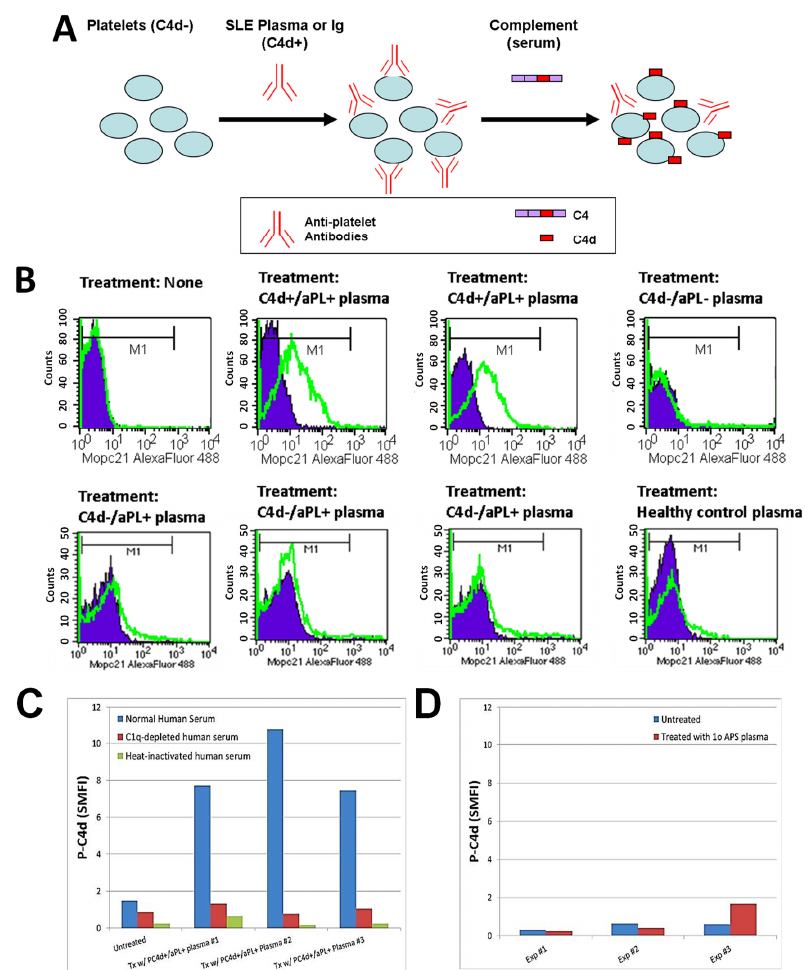
Figure 1. Induction of C4d deposition on the surface of platelets in vitro. ( A ) Schematic illustration of the in vitro P-C4d induction experiments. C4d-negative (C4d − ) cells are incubated with plasma or Ig isolated from C4d-positive (C4d+) SLE patients, and subsequently with normal human serum (complement). After treatment, levels of C4d deposited on platelet surfaces were analyzed by flow cytometry; ( B ) Platelets from a healthy individual were incubated with the plasma of two P-C4d+/aPL+ SLE patients, one P-C4d − /aPL − SLE patient, three P-C4d − /aPL+ SLE patients, and one healthy control, followed by incubation with complement. Note the high levels of C4d deposited on cell surfaces after treatment with P-C4d+/aPL+ SLE plasma, but not with P-C4d − /aPL − SLE plasma, P-C4d − /aPL+ SLE plasma, or healthy control plasma. Purple histogram: isotype control; green open histogram: anti-C4d; ( C ) C4d deposition was induced in vitro only when platelets were treated with P-C4d+/aPL+ plasma, followed by normal human serum. C1q-depleted or heat-inactivated human serum was incapable of inducing C4d deposition; ( D ) Plasma of patients with primary antiphospholipid syndrome was incapable of inducing C4d deposition on platelets in vitro. P-C4d: platelet-bound C4d; aPL: antiphospholipid antibodies; P-C4d+/aPL+: P-C4d positive/aPL positive; P-C4d − /aPL − : P-C4d negetive/aPL negative; P-C4d − /aPL+: P-C4d negetive/aPL negative; SLE: systemic lupus